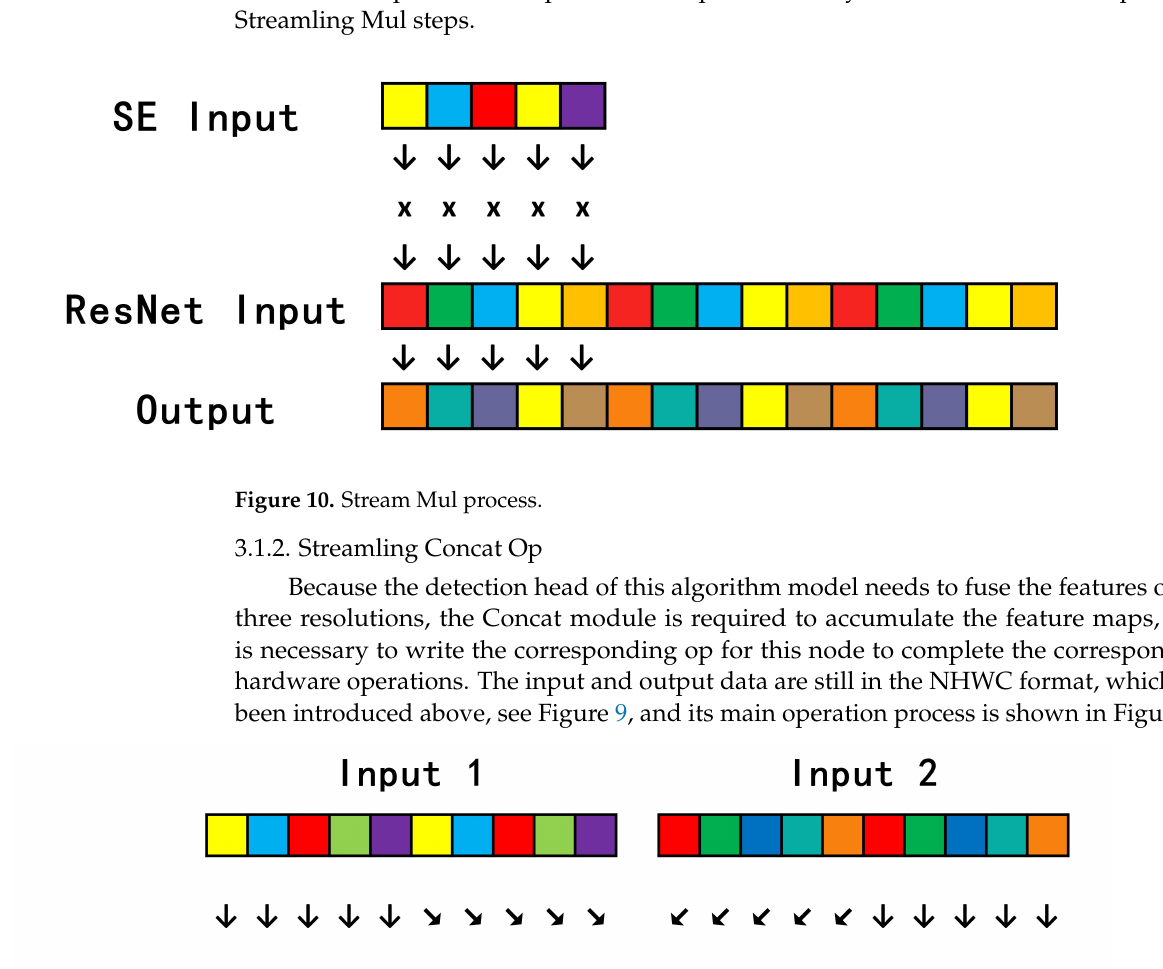
Figure 9. HLS stream data.